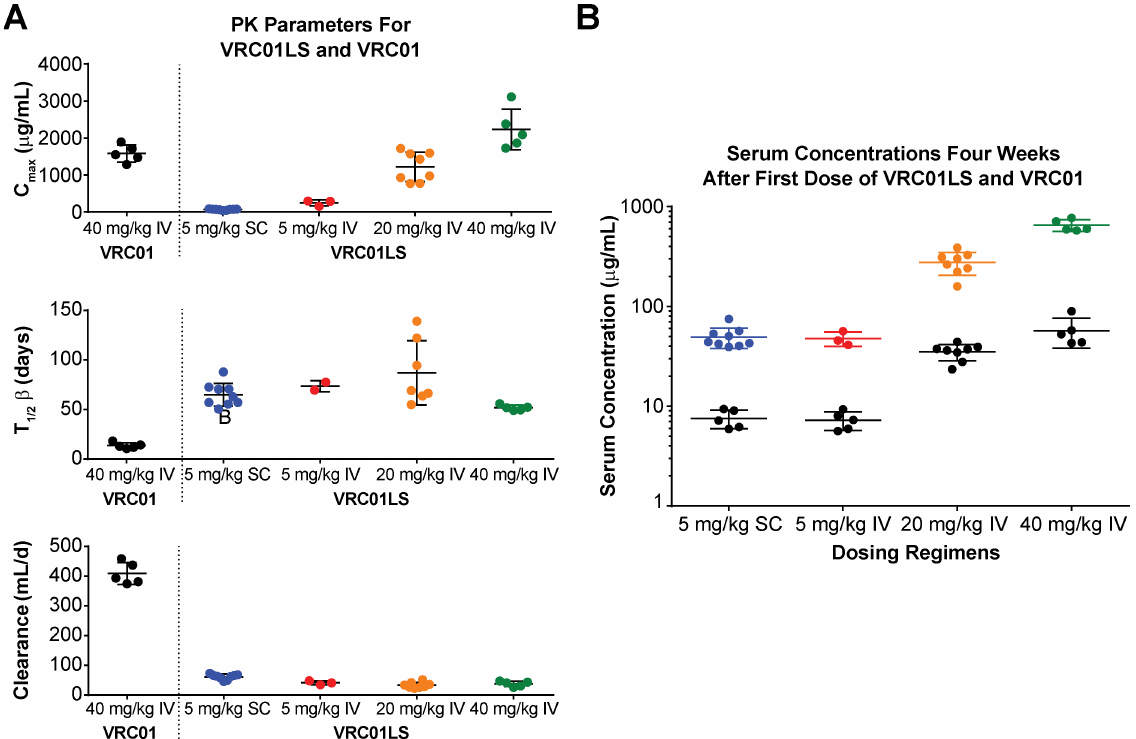
Fig 3. Post infusion serum antibody concentrations and PK parameters by dose and route. (A) C max (top panel)showing expecteddose-dependent increasesof VRC01LS,t 1/2 β (middle panel), and antibody clearance(bottom panel), showingsimilar values for doses and routes. Bars show mean values, with error bars indicating s.d. Previously published VRC01 data following40 mg/kg infusionare shown for comparison. (B) VRC01LS and VRC01 serum concentrations 4 weeks after a singleadministration, as indicatedon the x-axis. Each value is the mean of duplicatewells in the same plate. VRC01 data (black dots) were derivedfrom historicaldata. C max , maximal concentration; IV, intravenous; PK, pharmacokinetic; SC, subcutaneous; s.d., standarddeviation; t 1/2 β , elimination